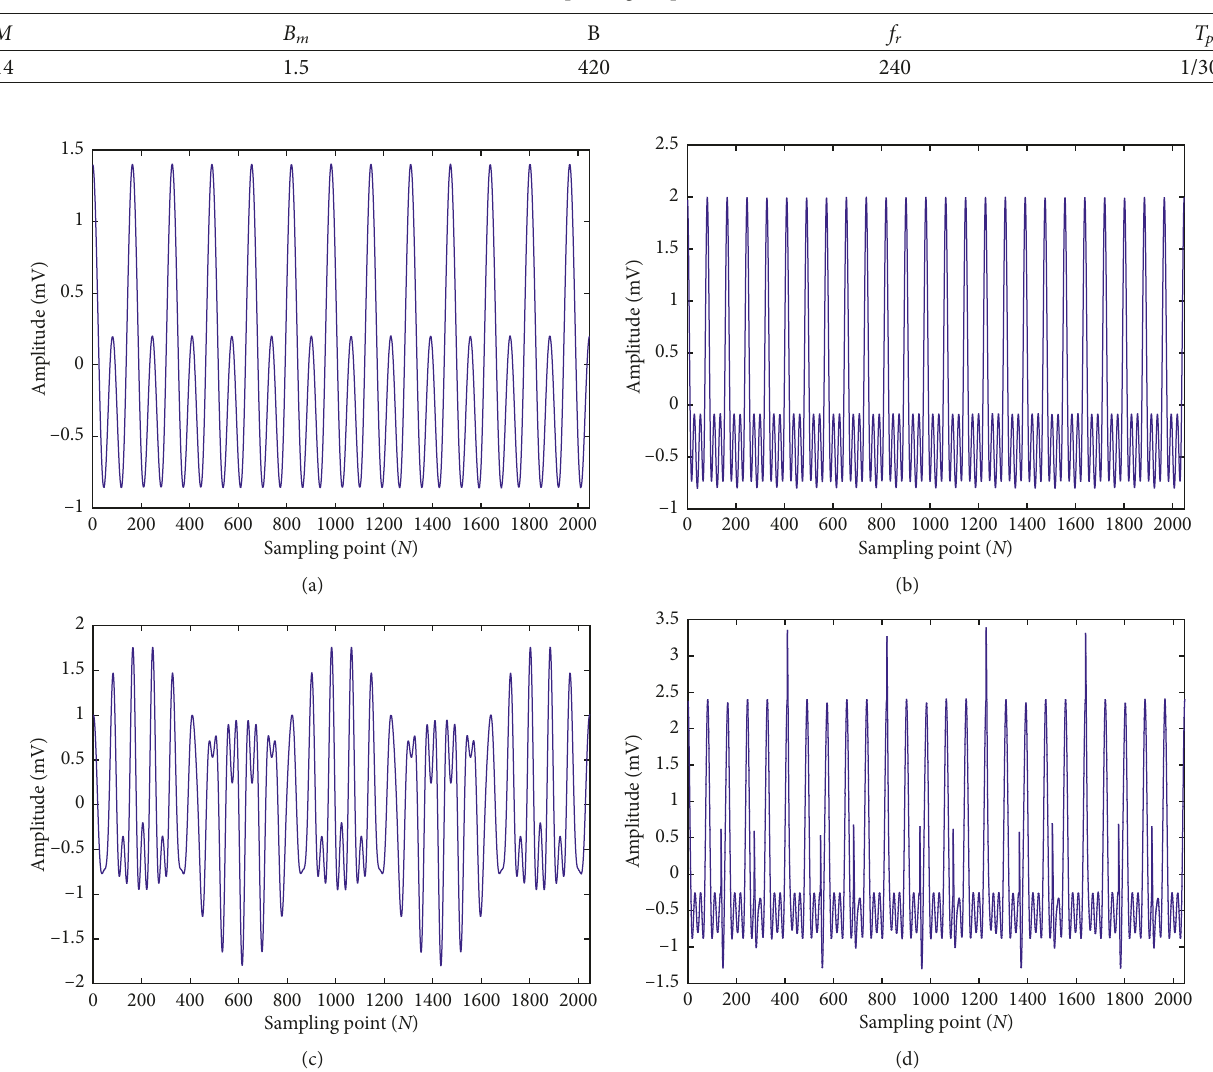
Figure 4: Oscillograms of various simulation signals. (a) Oscillogram of signal x x 3 ( t ). (d) Oscillogram of signal x 4 ( t ).